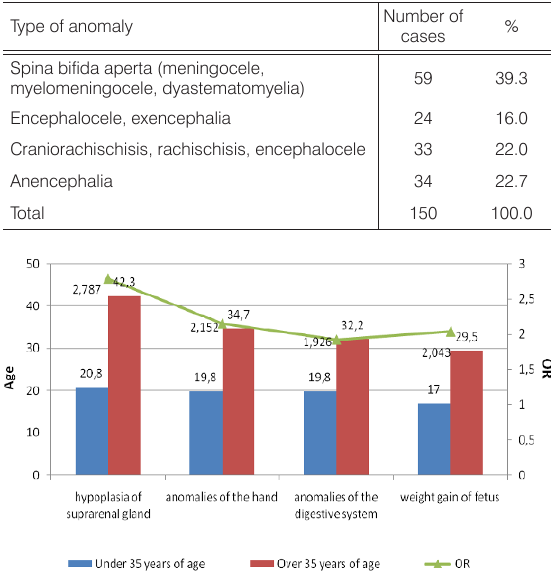
Figure 1. Associated abnormalities in fetuses with NTDs, deter - mined by age of mother.